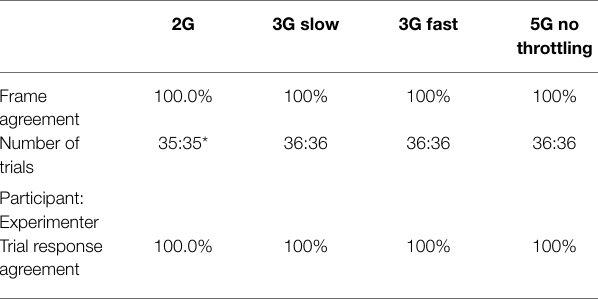
TABLE 1 | Internet speed